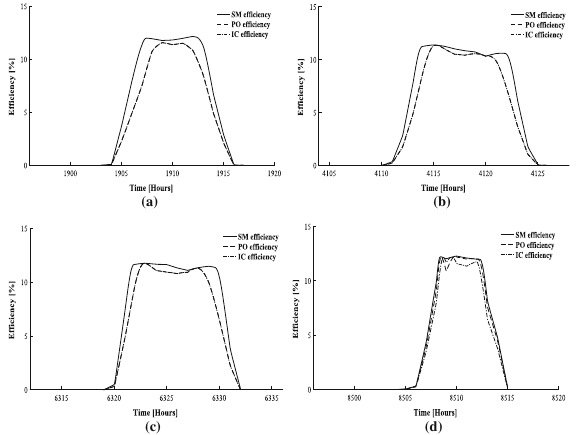
Fig. 10 Module Efficiencies using different MPPT techniques on the Poly-Si PV array MSX60 for a March 21, b June 21,